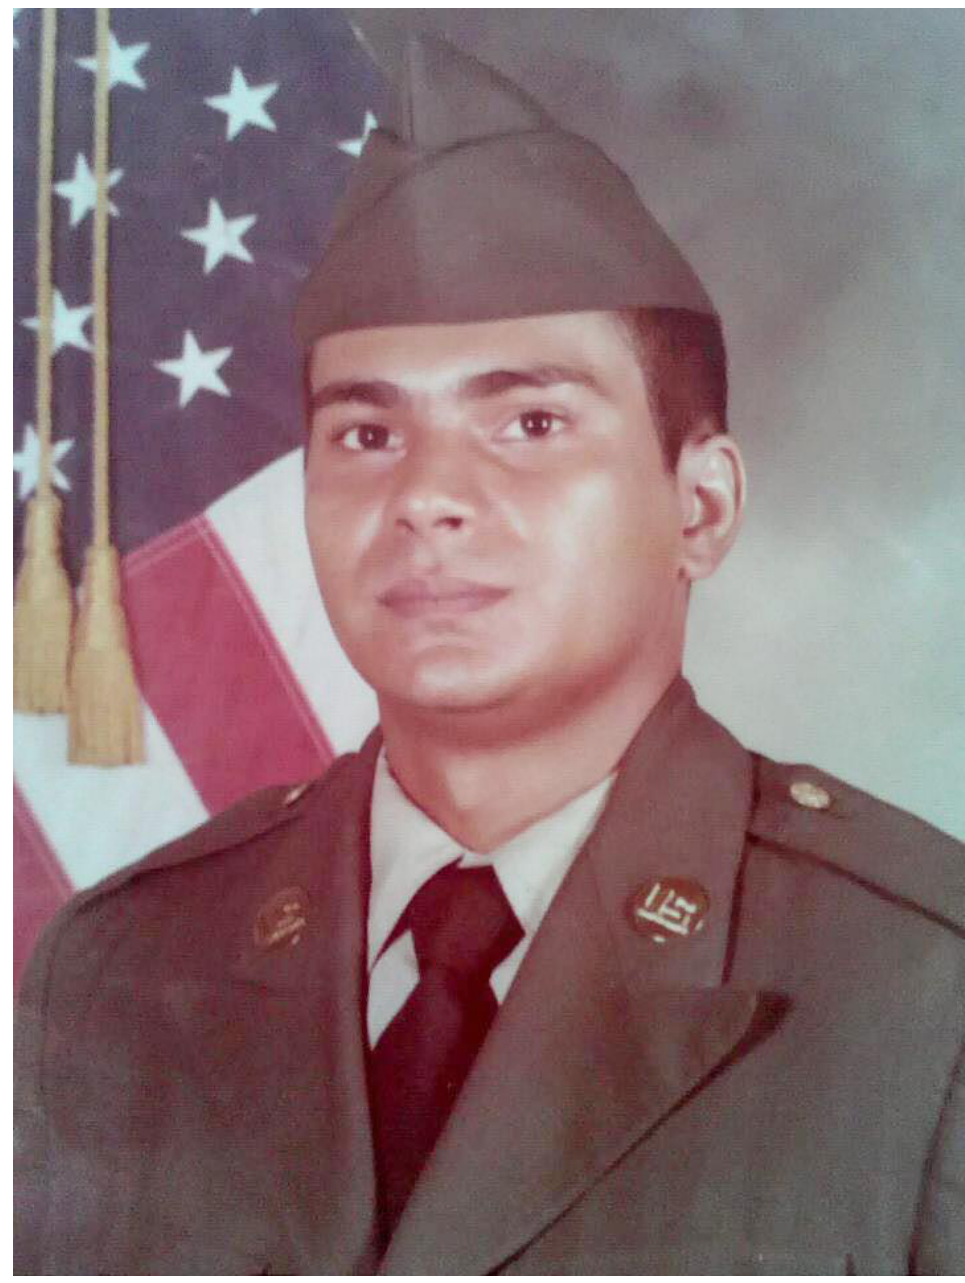
Jezabeth Roca Gonzalez, Gringolandia , 2017-2018,